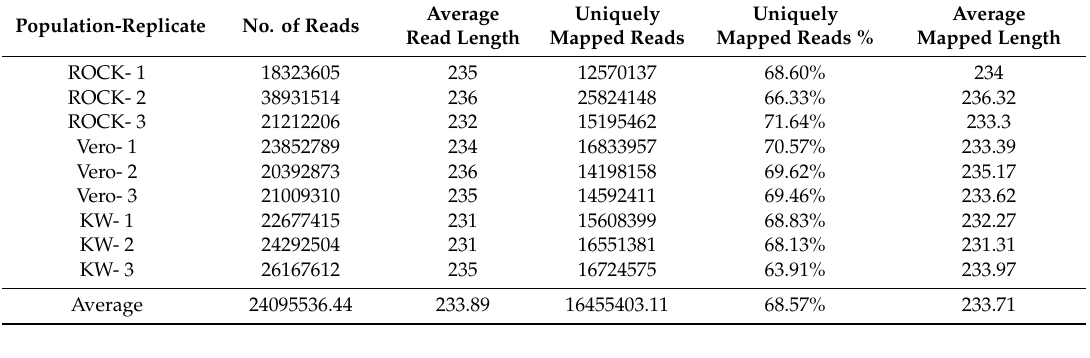
Table 4. Mapping summary.